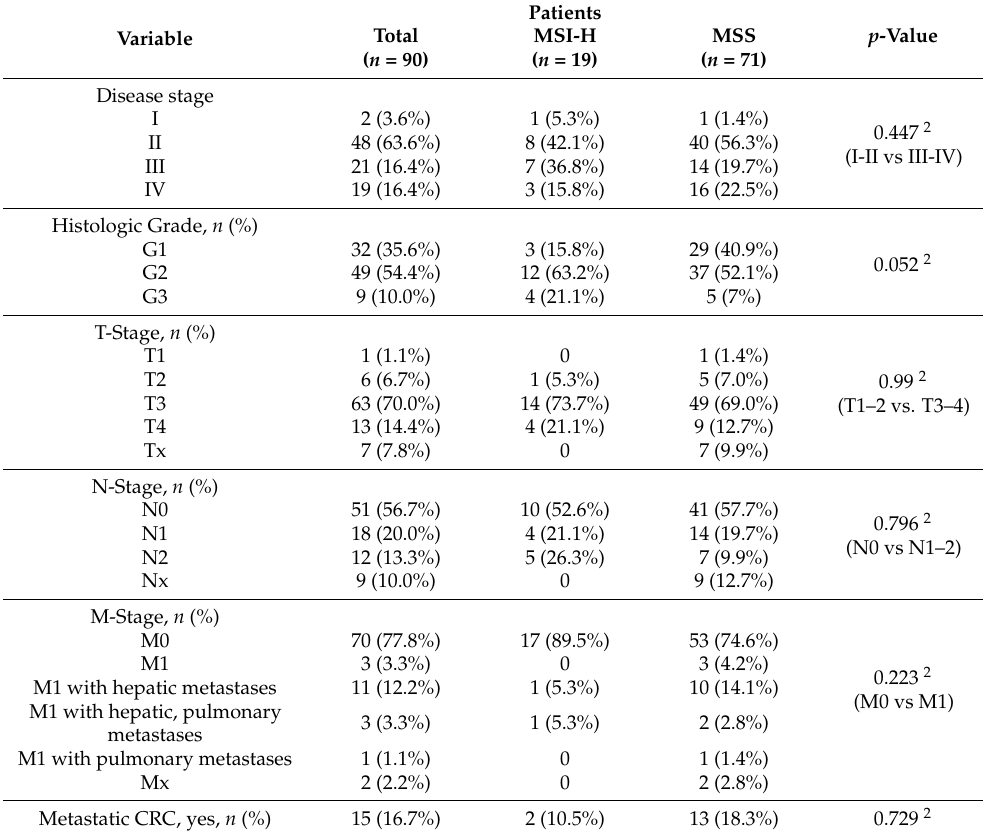
Figure 2. Kaplan– survival curves for patients with colorectal carcinoma by MSI status. MSI, mi- crosatellite instability; MSI-H, high microsatellite instability; MSS, microsatellite stability. Table 2. PFS comparison between MSI-H and MSS patients. PFS